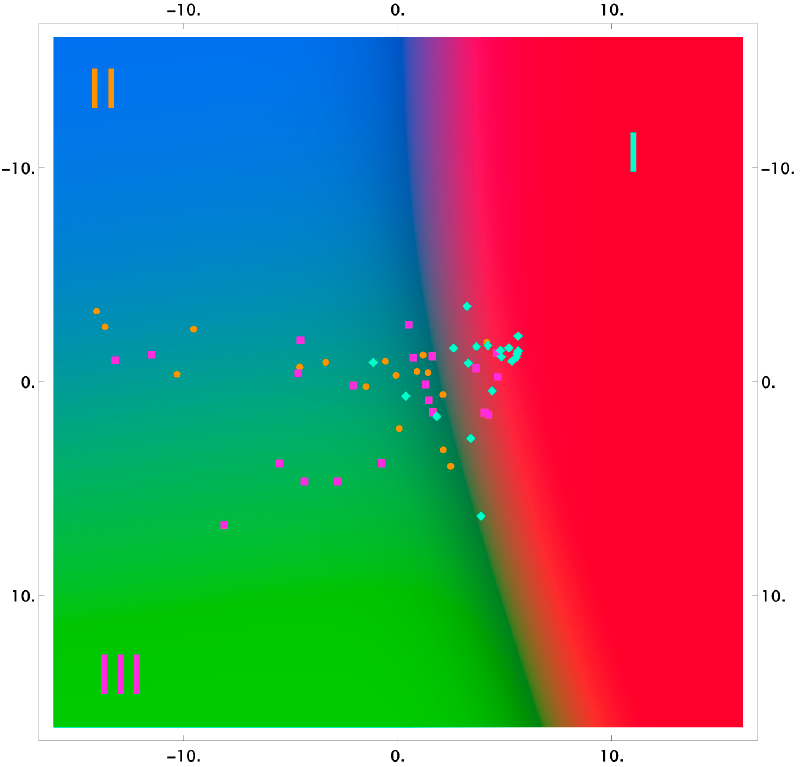
Figure 4. The 2D probability distribution of each class as a function of the features (dentin) of the studied groups I–III.